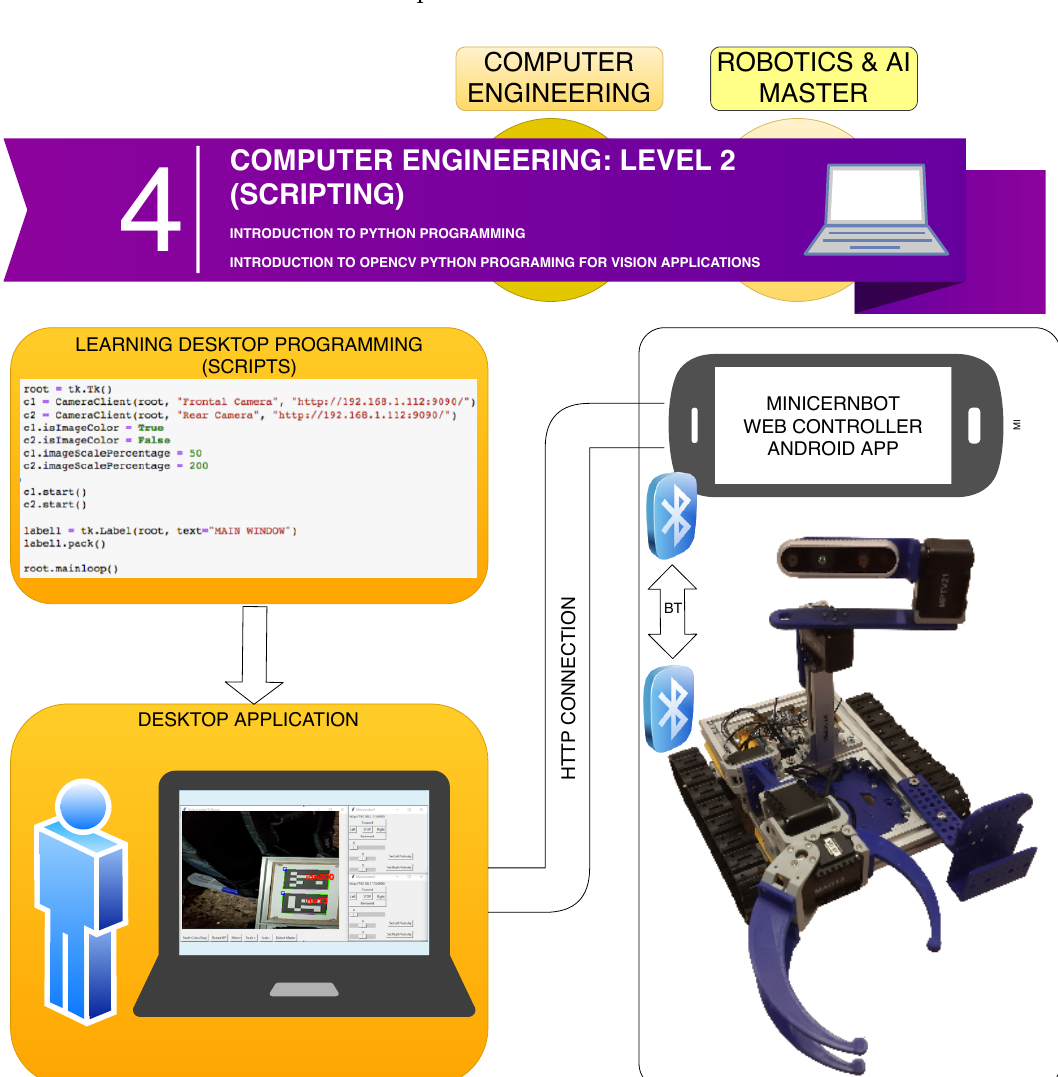
Figure 17. Software architecture for the Computer Engineering Level 2 exercise